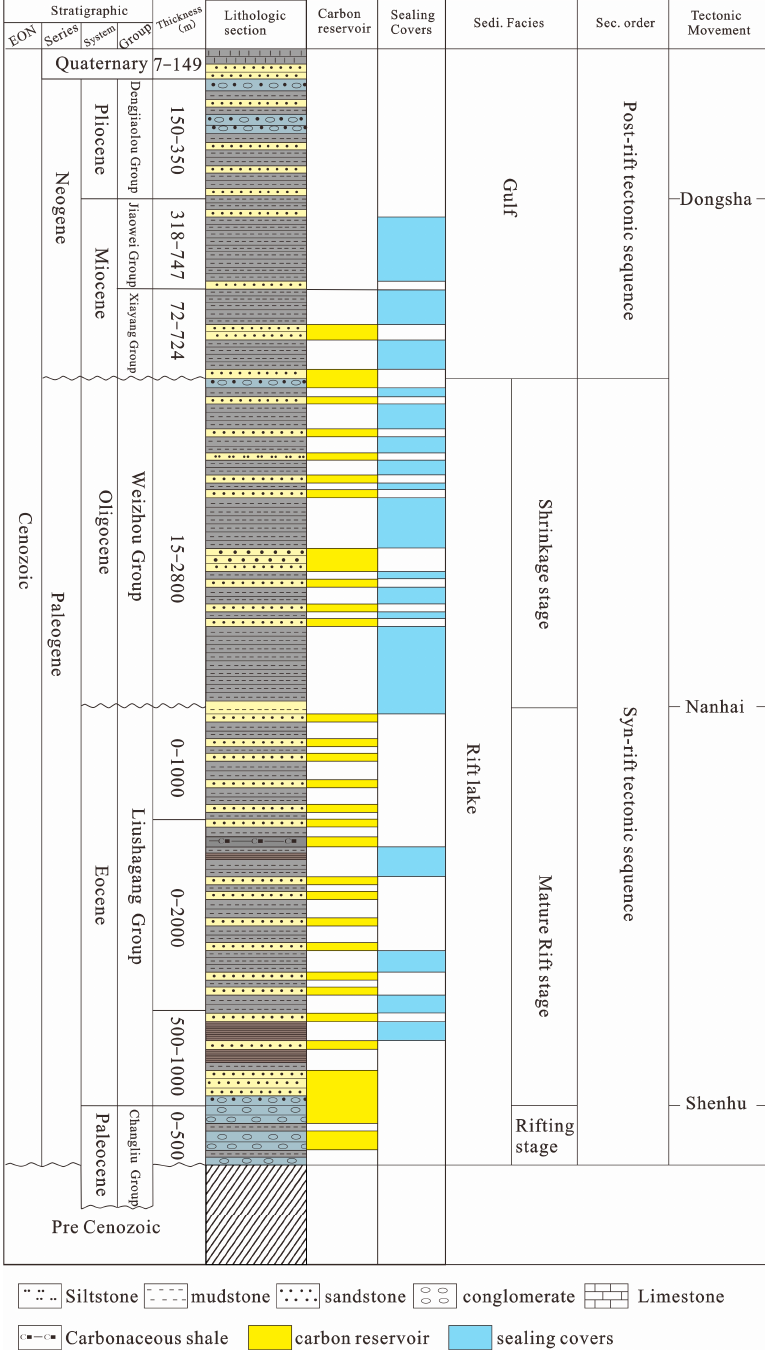
Figure 3. Reservoir-caprock assemblages of the Beibu Gulf